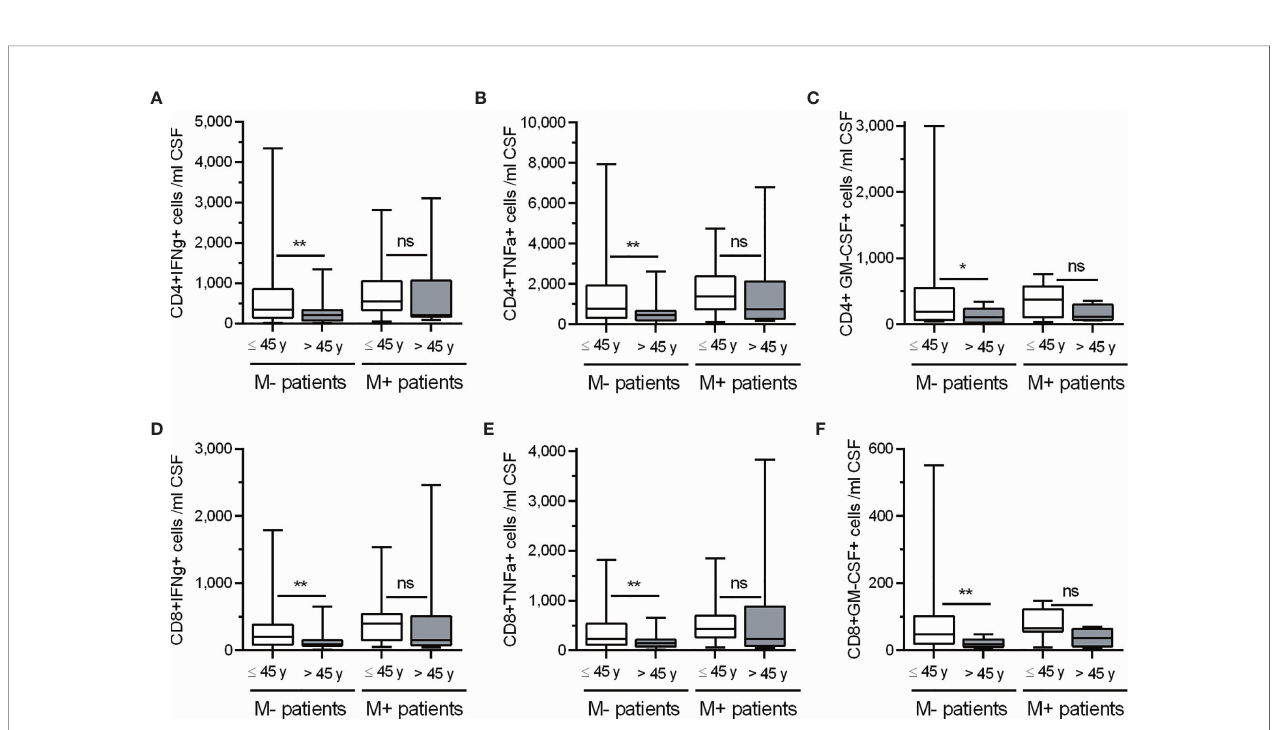
FIGURE 3 | Changes in CSF CD4+ and CD8+ T lymphocytes producing cytokines in M- and M+ patients according to age. Absolute cell numbers (N.) of CD4+ (A – C) and CD8+ (D – F) T lymphocytes producing Interferon-gamma (IFNg), Tumor Necrosis Factor-alpha (TNFa) and Granulocyte-Macrophage Colony Stimulating Factor (GM-CSF) in patients lacking (M-, n=105) and showing (M+, n=36) lipid-speci fi c oligoclonal IgM bands, and classi fi ed according to their age in ≤ 45 years (white bars) and > 45 years (grey bars). ns, not signi fi cant; y, years. *p < 0.05; **p <